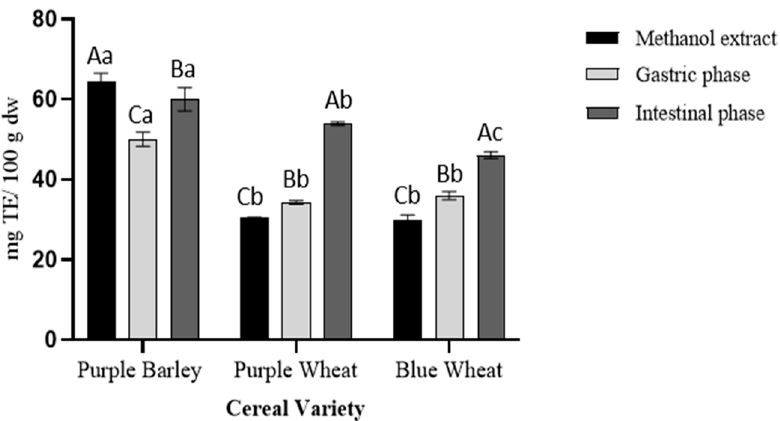
Figure 2. Total antioxidant activity of extracts from digestion of pigmented cereal flour compared with a methanol extract using a FRAP assay. Data shown is blank corrected, expressed as mg TE/100 g dry weight cereal flour and represent mean ± SD; n = 3. Different capitalized alphabets represent significant differences within a cereal variety. Different lowercase alphabets represent significant differences between cereal varieties.